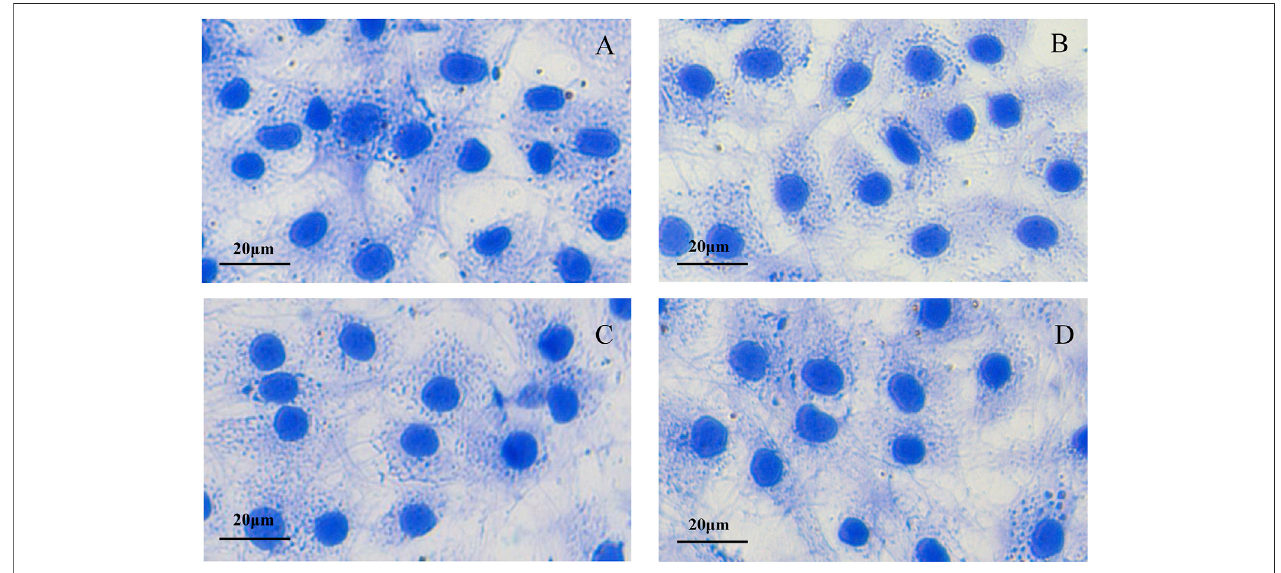
FIGURE 5 | The effect of Sr on the cytoskeleton in bovine chondrocytes stained with Coomassie blue. (A) 0 μ g/ml. (B) 0.1 μ g/ml. (C) 1 μ g/ml. (D) 10 μ g/ml.